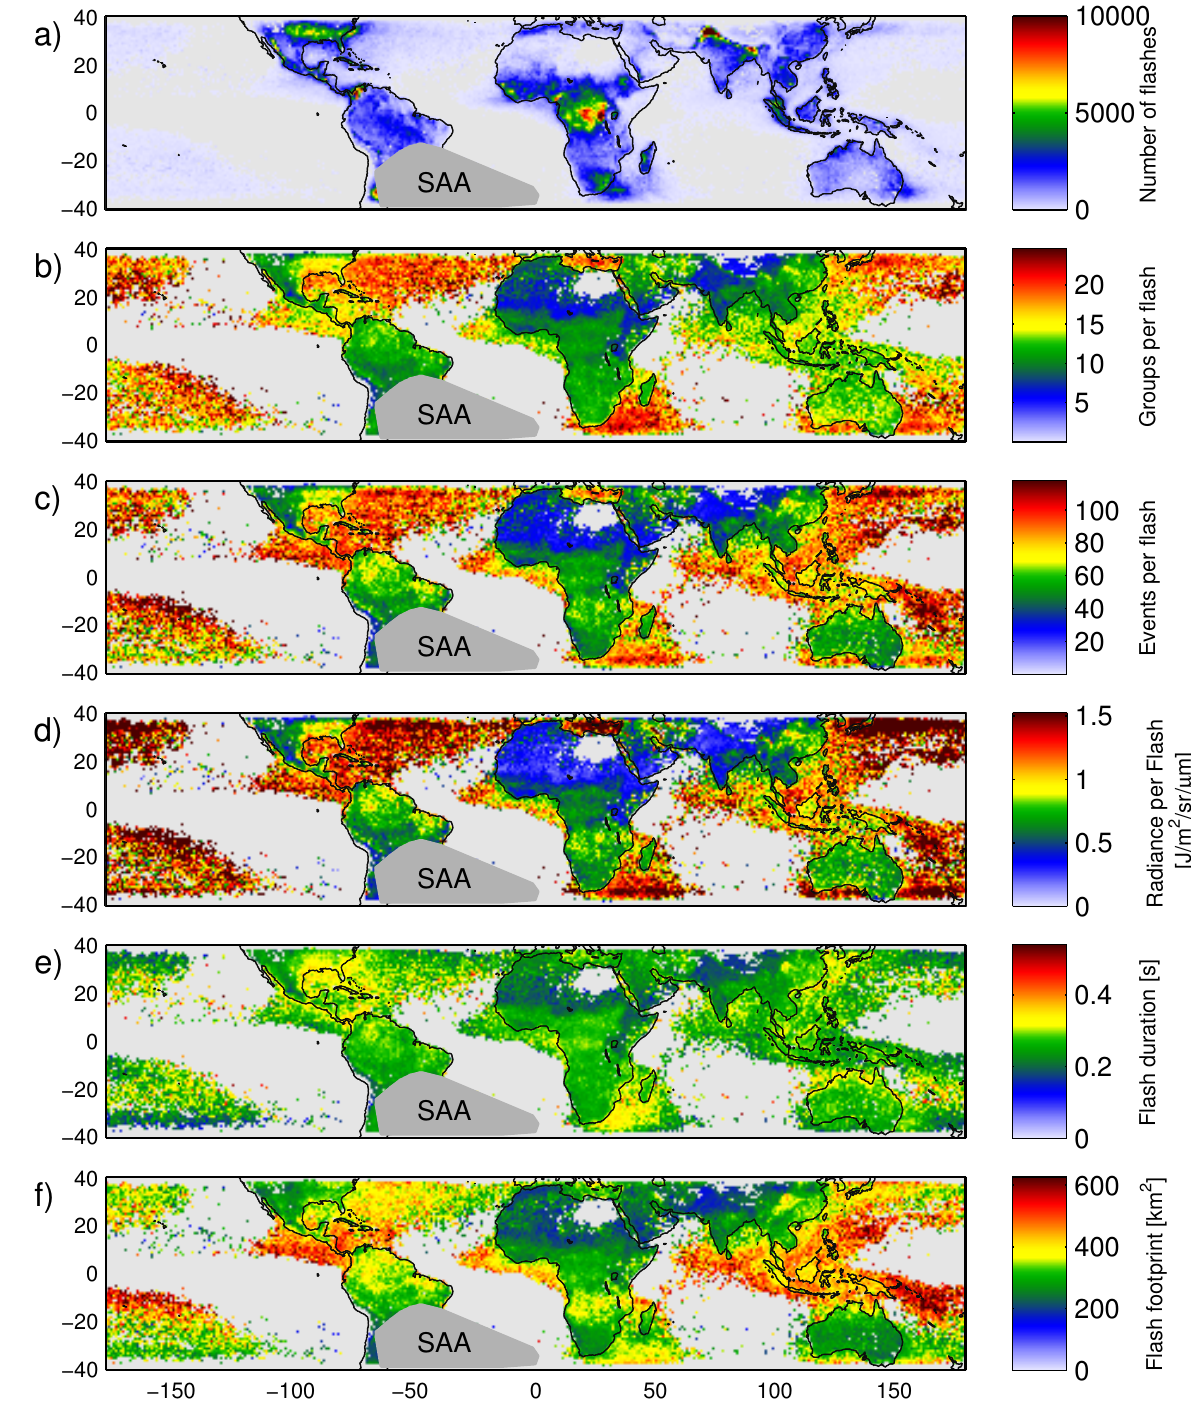
Figure 2. (a) Total number of flashes derived from LIS (1998–2012) on 1 ◦ × 1 ◦ grid. Parts of South America are masked out by the applied quality flags as a consequence of the SAA. (b–f) Mean flash properties, i.e. groups (b) , events (c) , radiance (d) , duration (e) , and footprint (f) per flash. Grid pixels with less than 50 flashes and the area affected by the SAA are discarded (light/dark grey, respectively). The color scale of panels (b) to (f) ranges from 0 to twice the respective global mean value (see first row in Table 3). The corresponding data shown in this figure is provided as hdf files in the